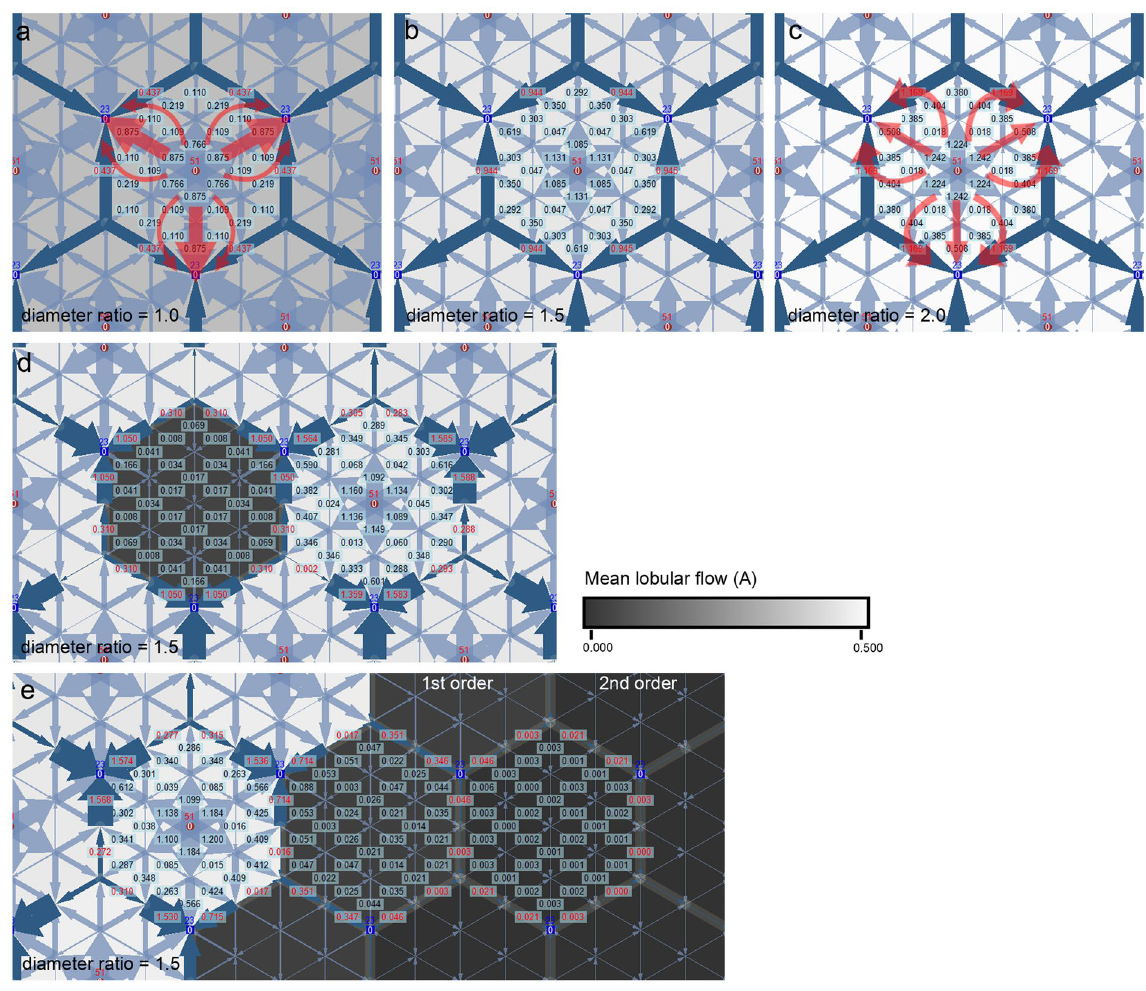
Figure 3. Electric circuit simulation of the choroid. ( a – c ) The normal choroid shows that electric currents follow the voltage gradient and do not cross the boundary of the hexagon. As the resistance of the boundary becomes lower, the blood flows become more evenly distributed in the hexagon. ( d ) When one anode is disconnected from the hexagon, the voltage gradient is reversed. Electric currents flow from the adjacent hexagons and cross the boundary to the disconnected hexagon, but at very low level. ( e ) Reduction of electric current is more severe in sectorial disconnection. Diameter ratio indicates ratio of the collector venule at the lobular boundary and the choriocapillaris. Electric resistance is inversely proportional to the fourth power of the radius (r 4 ) by Poiseuille’s equation.